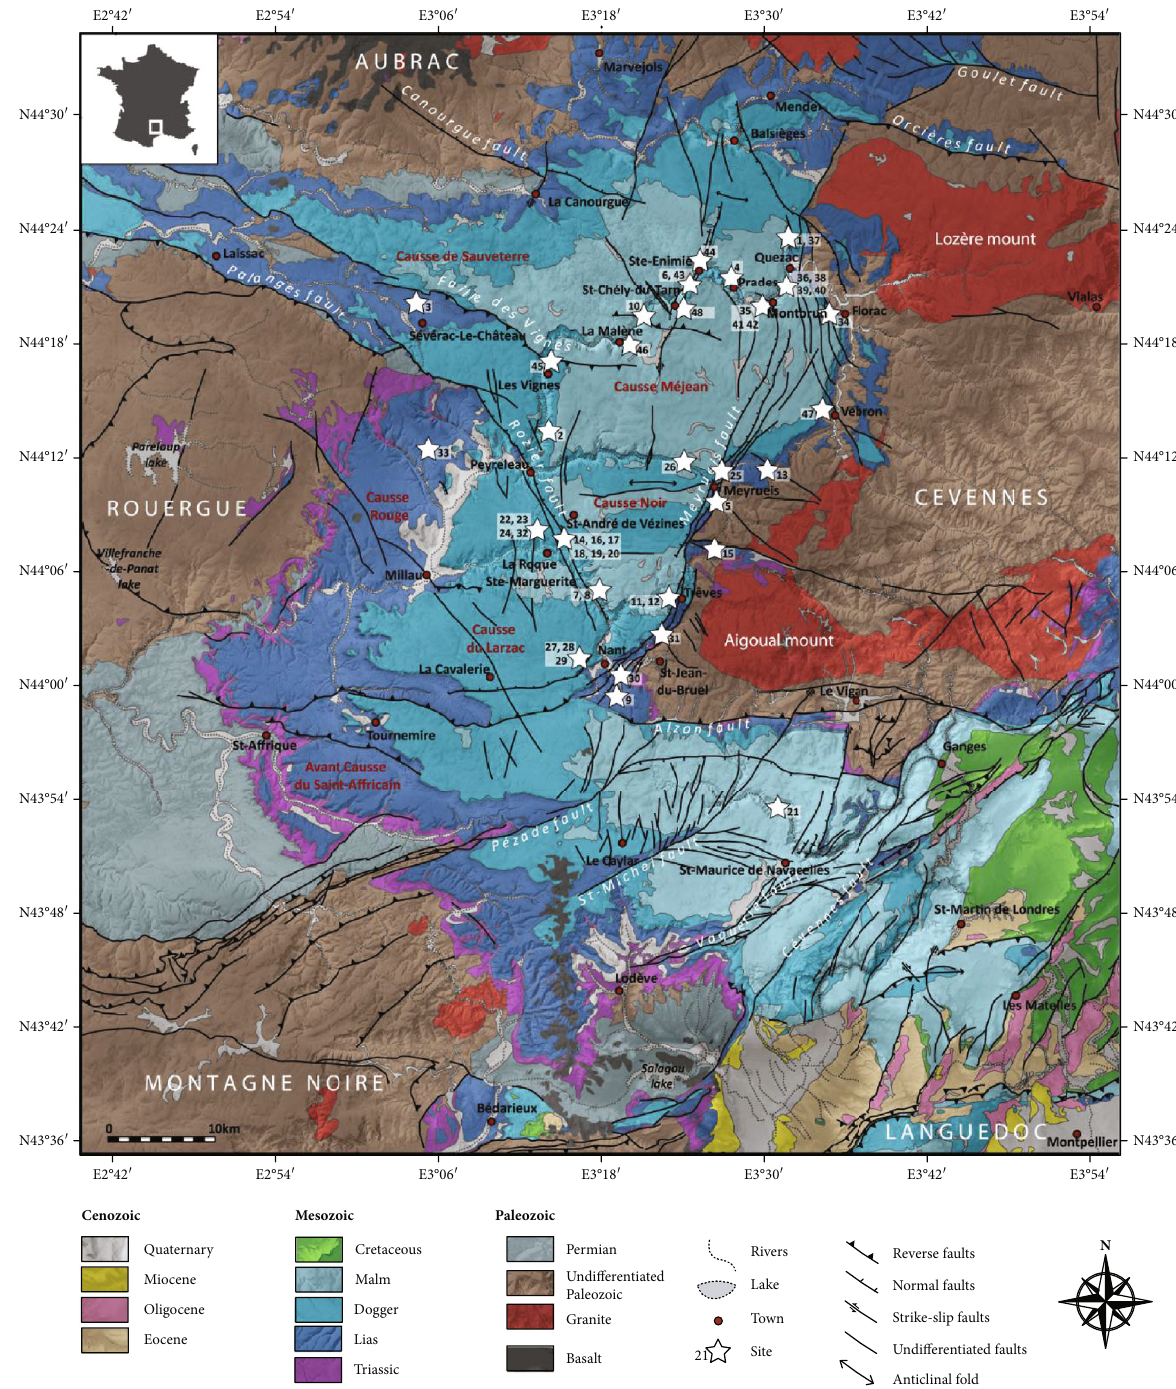
Figure 2: Structural scheme of the Grands Causses area. Modi fi ed after 1/50,000 geological maps [91 – 114]. See Table 1 for details about the studied